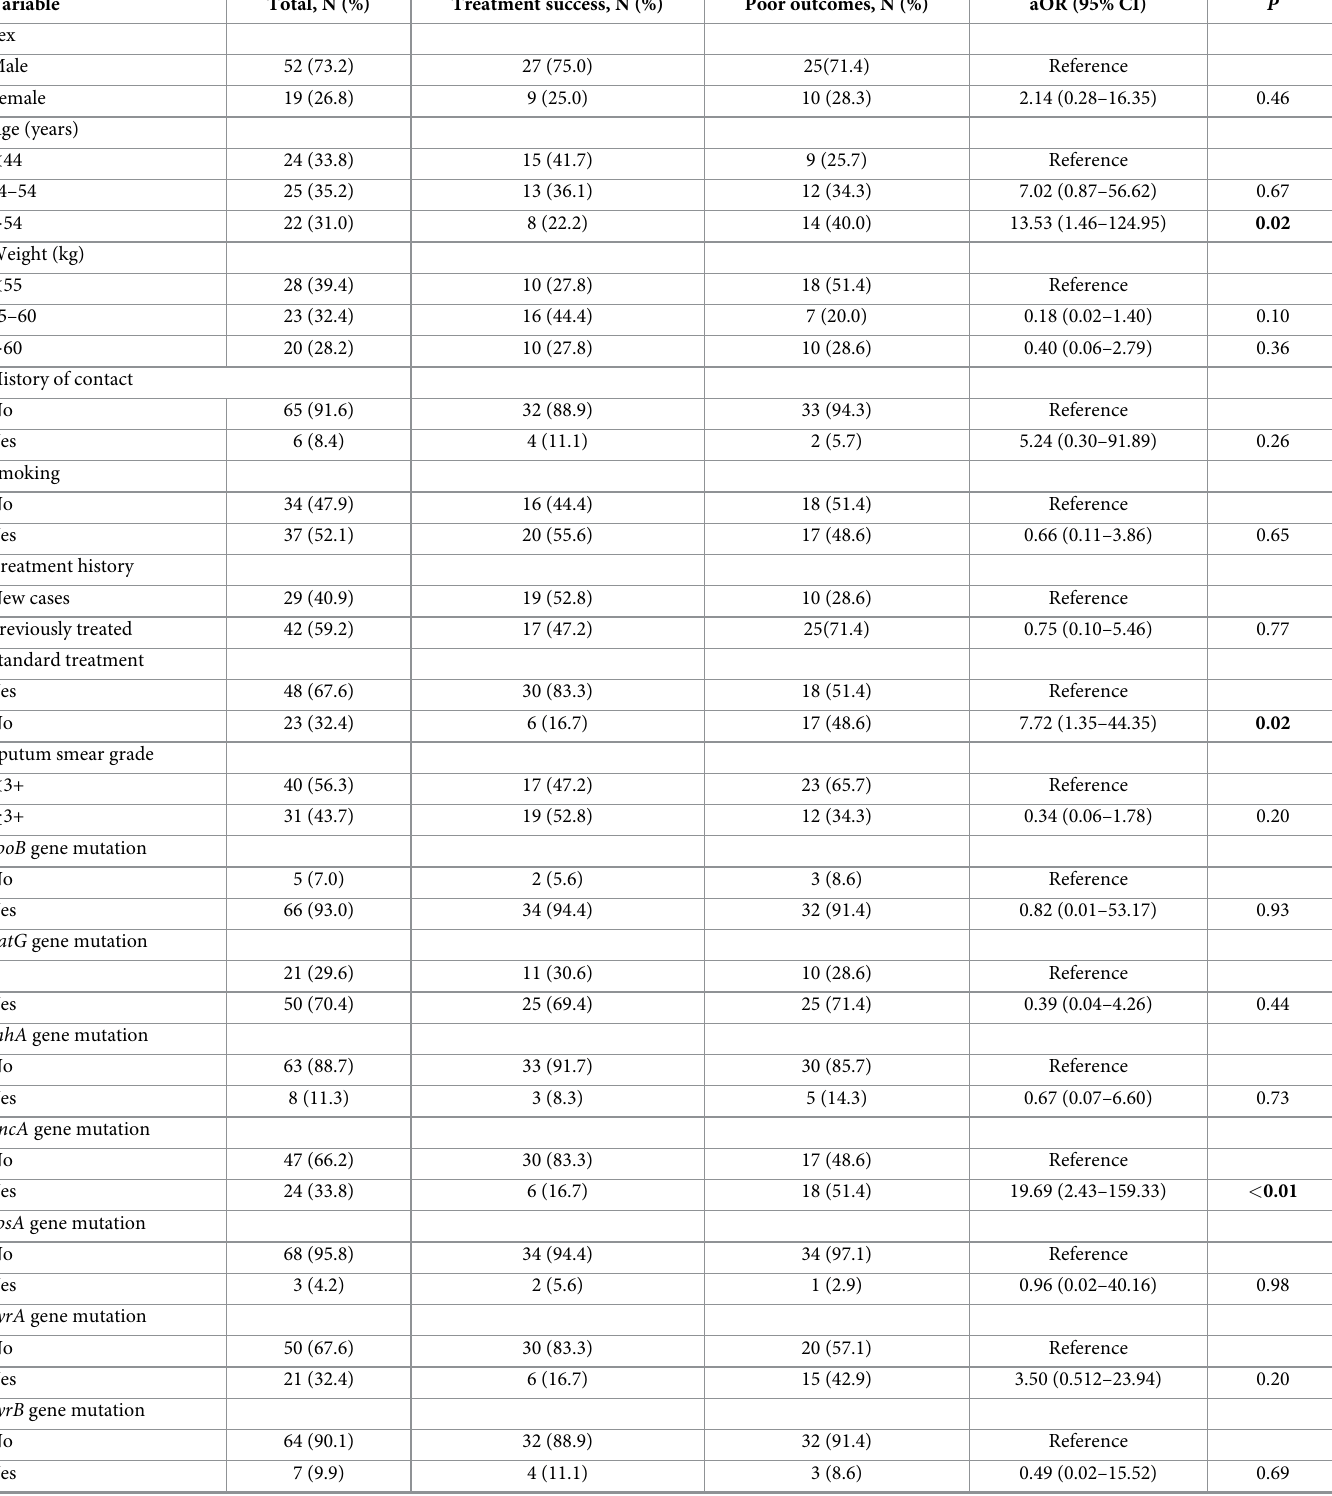
Table 5. Multivariable logistic regression analysis of drug resistance gene mutations and treatment